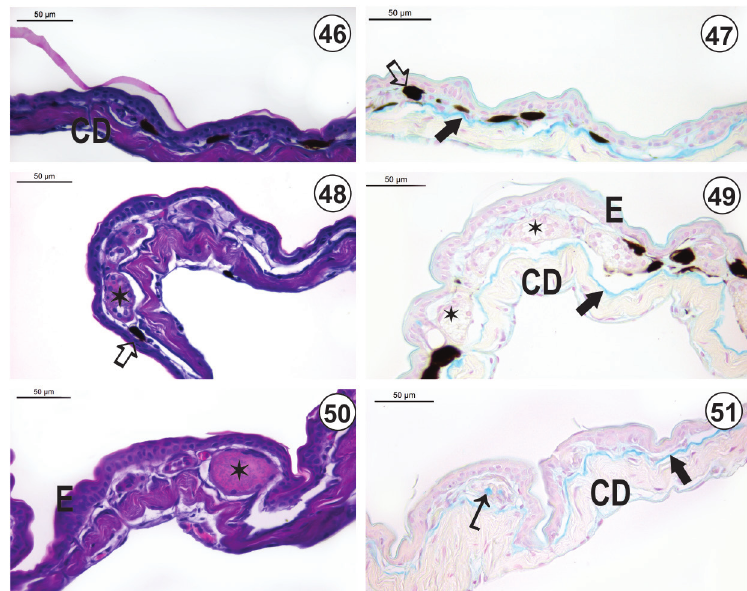
Figures 46–51. Light micrograph of the integument of O. v-signata : (46) Dorsal region (HE-staining); (47) Dorsal region (AB-method); (48) Ventrolateral region (HE-staining); (49) Ventrolateral region (AB-method); (50) Ventral region (HE-staining); (51) Ventral region (AB-method). Melanophores ( _ ) occur in the spongious dermis that is poorly developed in the dorsal region. The EK-layer ( Æ ) is a continuous layer in all integument regions. Apocrine glands ( ¬ ) with heterogeneous content occur in both ventrolateral and ventral regions. Serous glands are visualized in both dorsal and ventrolateral integument. Mixed glands (  ) are observed in the ventral region. E = epidermis; CD = compact